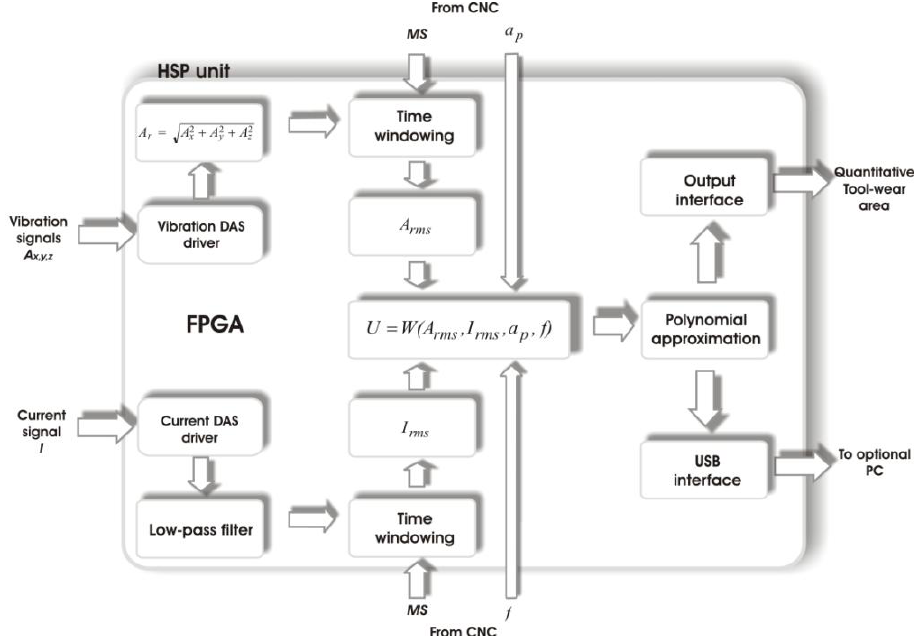
Figure 3. Block diagram of the FPGA-based HSP